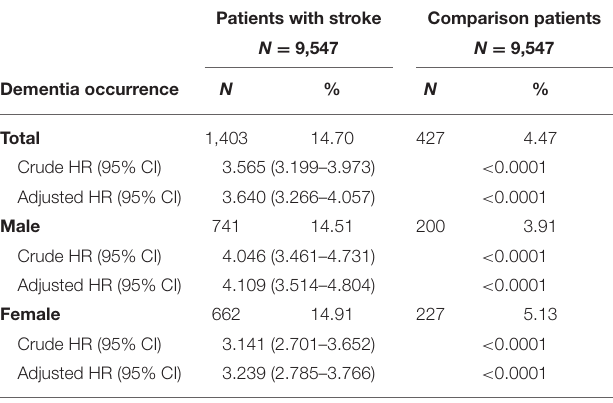
TABLE 2 | Crude and adjusted HRs of dementia among patients and controls in each gender group during a 3-year follow-up period from initial treatment. Patients with stroke Comparison patients